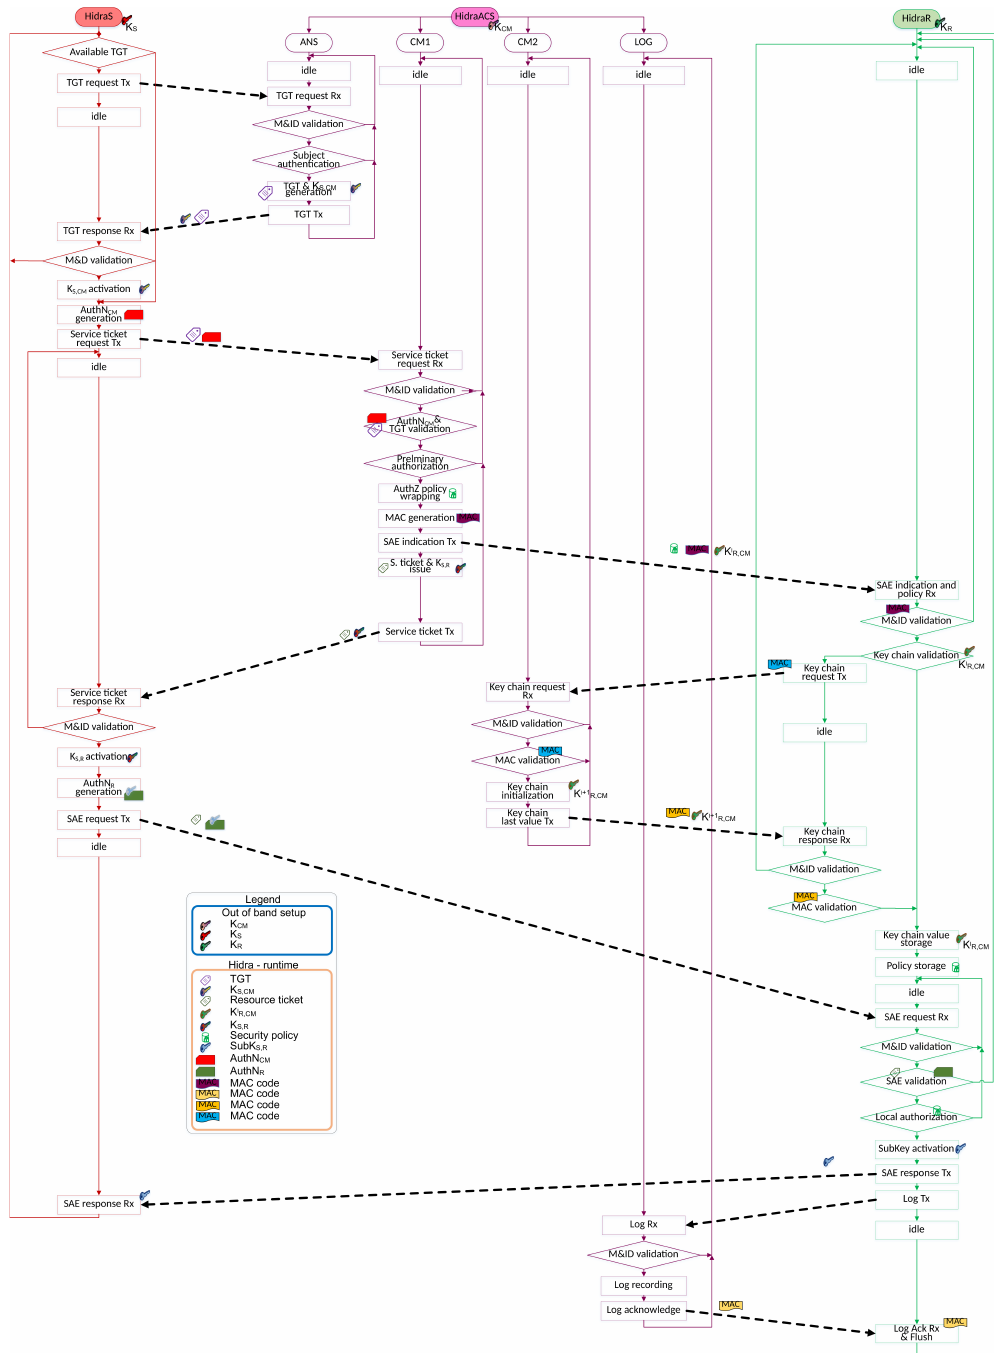
Figure 6. Hidra software flow